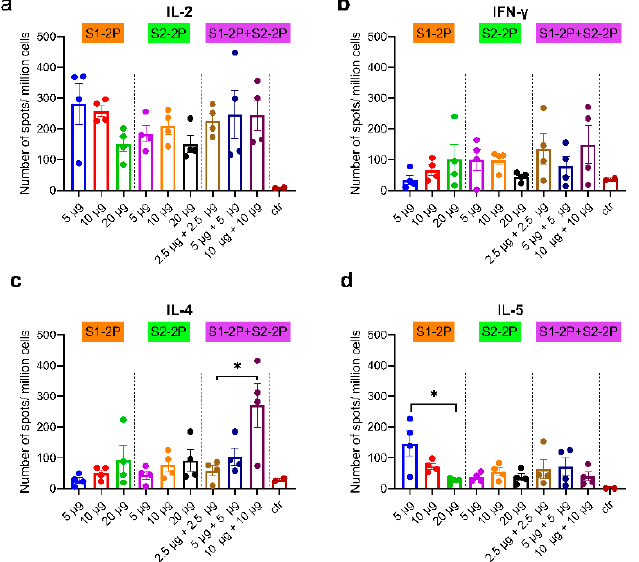
Figure 6. Spike-specific cellular immune responses. IL-2 ( a ), IFN- γ ( b ), Il-4 ( c ), and IL-5 ( d ) T cell responses of splenocytes from each mouse were shown as mean ± SEM for each animal. The dots of different colors represented mouse serum of different immune groups. Statistically significant differences were compared using one-way ANOVA or t -test and are indicated as * for p < 0.05.